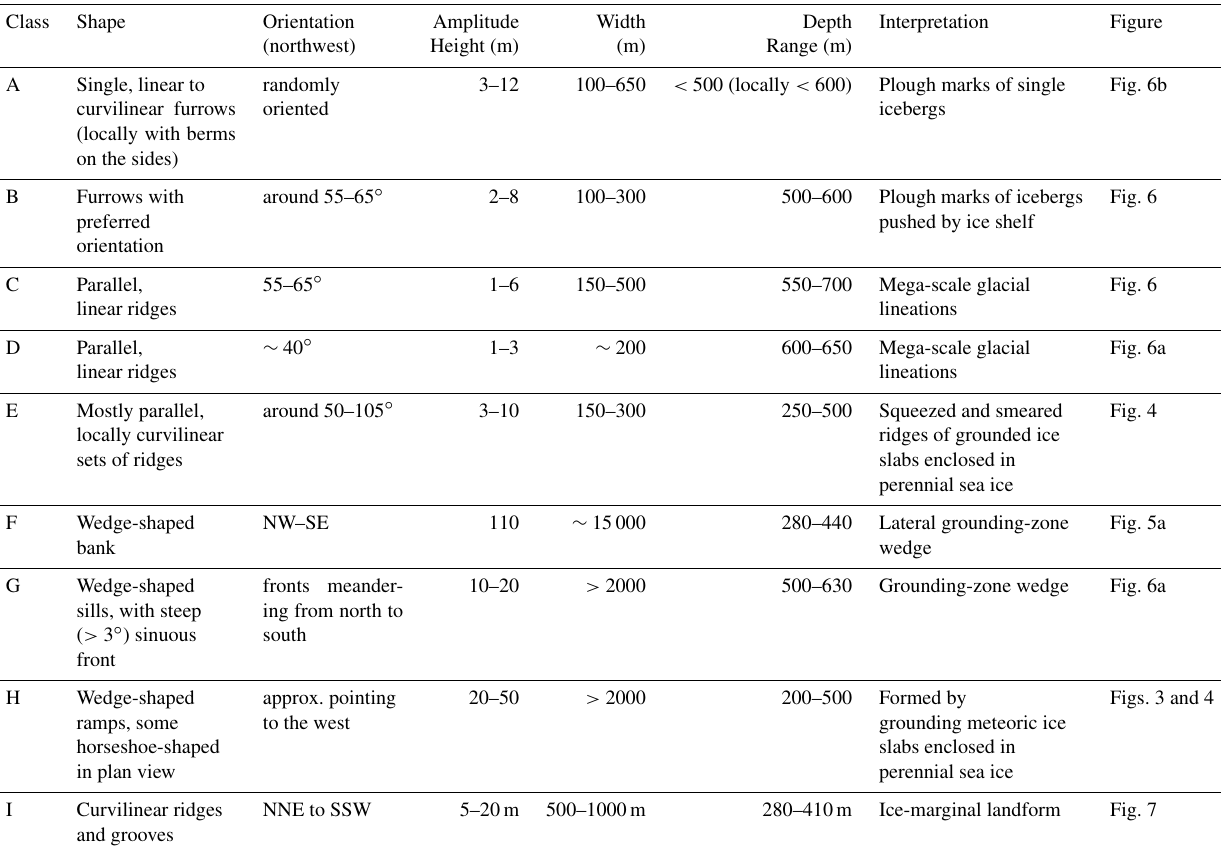
Table 2. Morphological classes identified in the swath bathymetric data and their